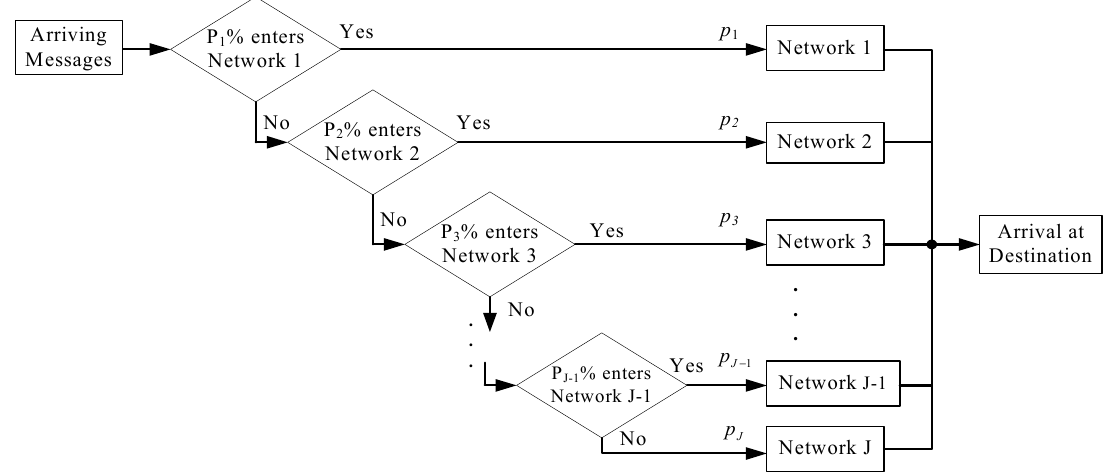
Figure 3. Queueing network design of J networks.